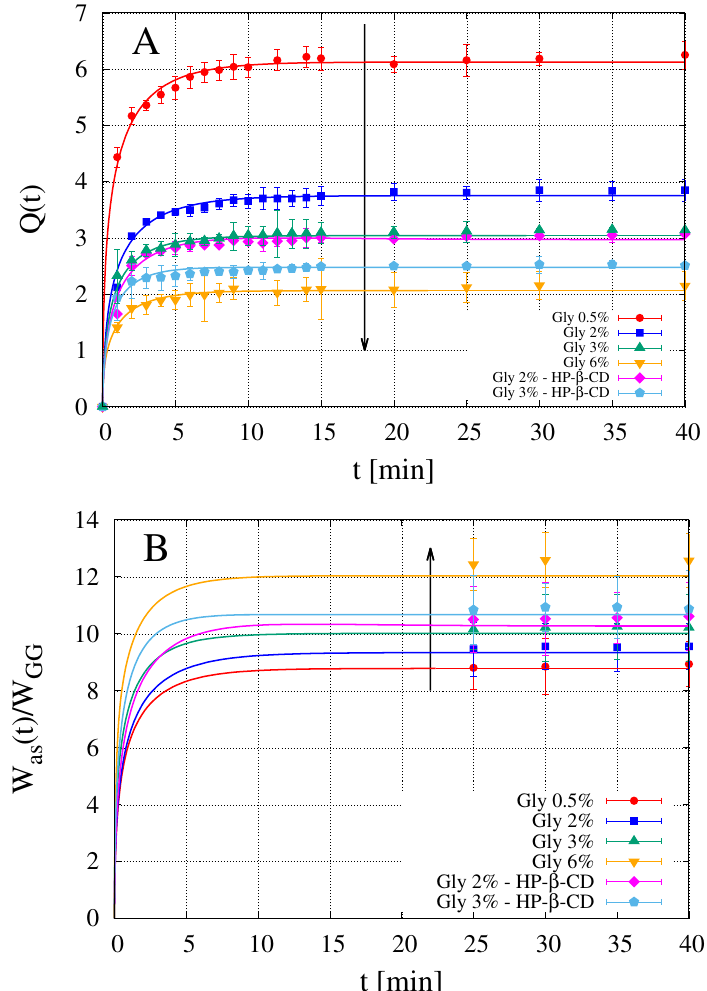
Figure 5. Dynamic swelling data in simulated saliva (pH = 6.7) at T = 37 ◦ C for GG-Gly films with and without HP- β -CD. Continuous lines represent model predictions. The corresponding diffusivity values D s and D CD are reported in Table 2. ( A ) Q ( t ) = ( W ( t ) − W 0 ) / W 0 vs. t ; ( B ) rescaled amount of absorbed water as a function of time. Points represent the asymptotic experimental values evaluated from Equation